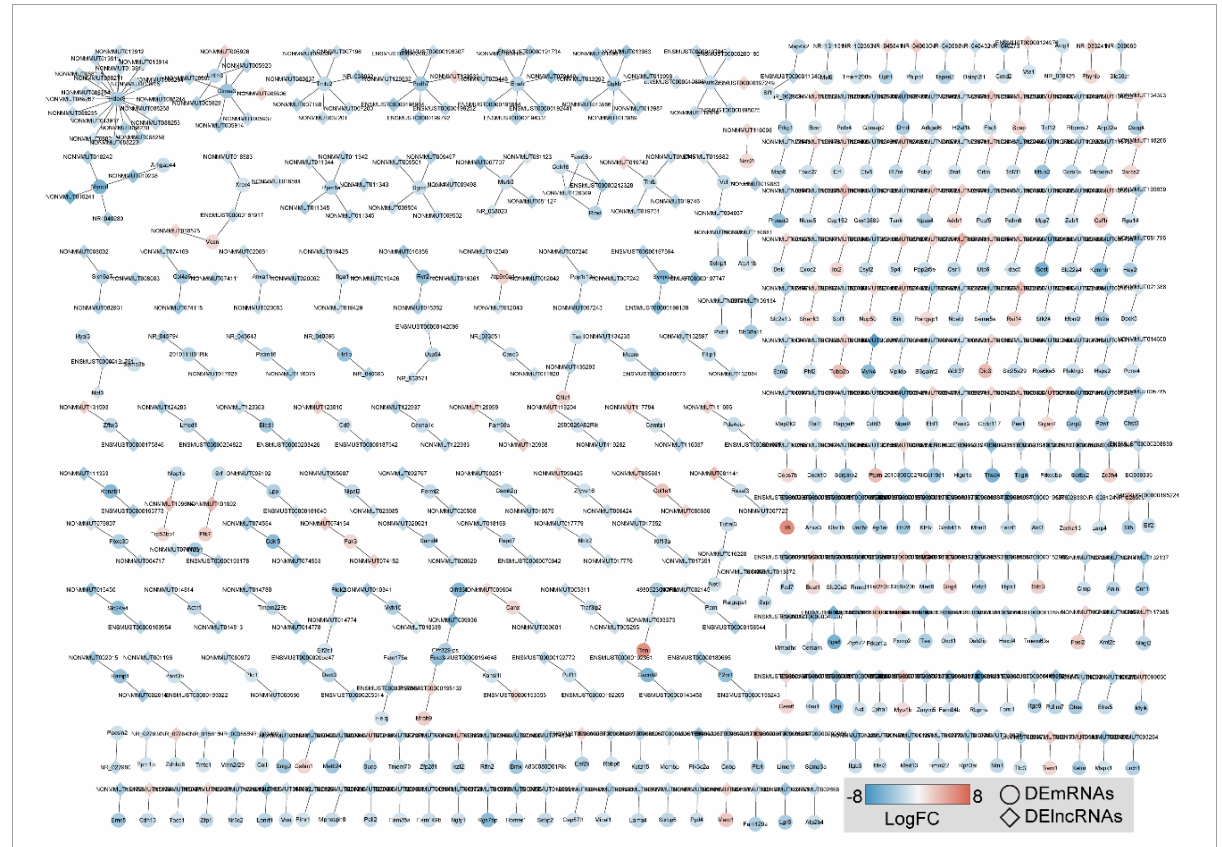
FIGURE8 Construction of DE long-non-coding RNAs (DElncRNAs)-mediated cis -regulatory networks in aortic dissection (AD) tissues induced by chronic intermittent hypoxia (CIH) and Ang II. A total of 486 lncRNA–mRNA regulatory pairs were identified in AD tissues. The red to blue color gradient indicates the up- to downregulation of DE lncRNAs/mRNAs indicated by logFC; the circular nodes represent mRNAs, the rhombic nodes represent long-non-coding RNAs